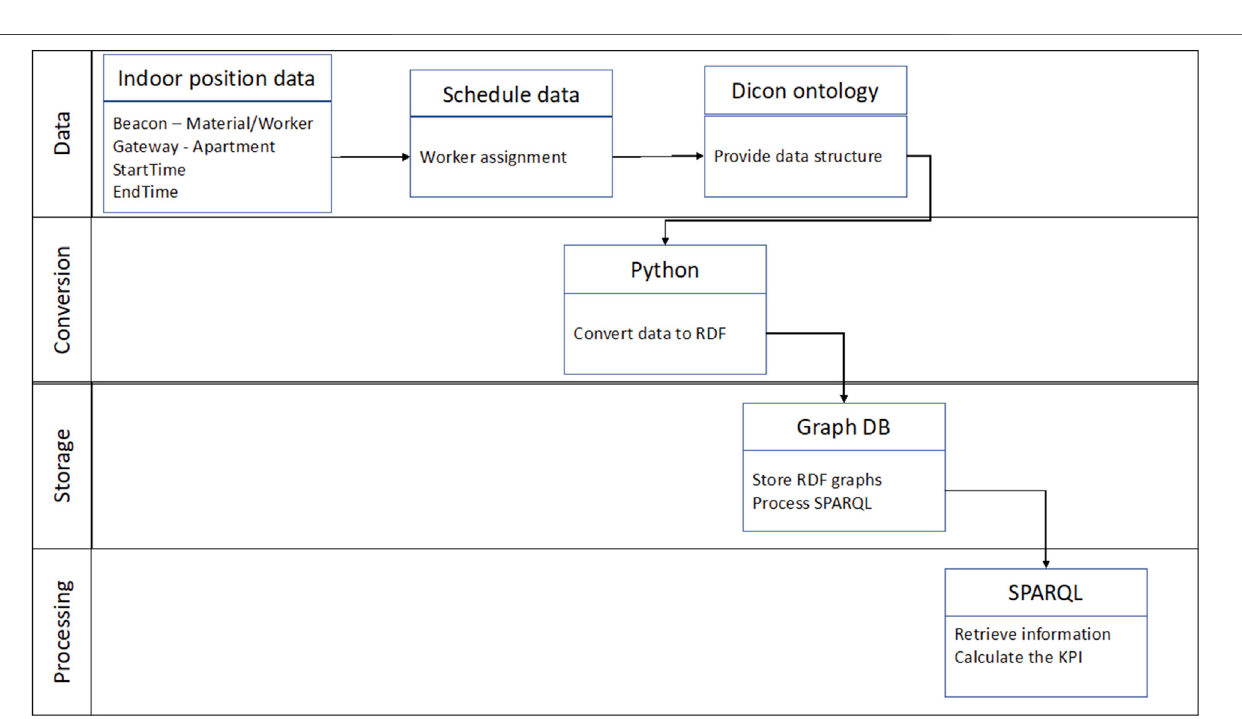
FIGURE 5 | Detailed process of linked data framework implementation.